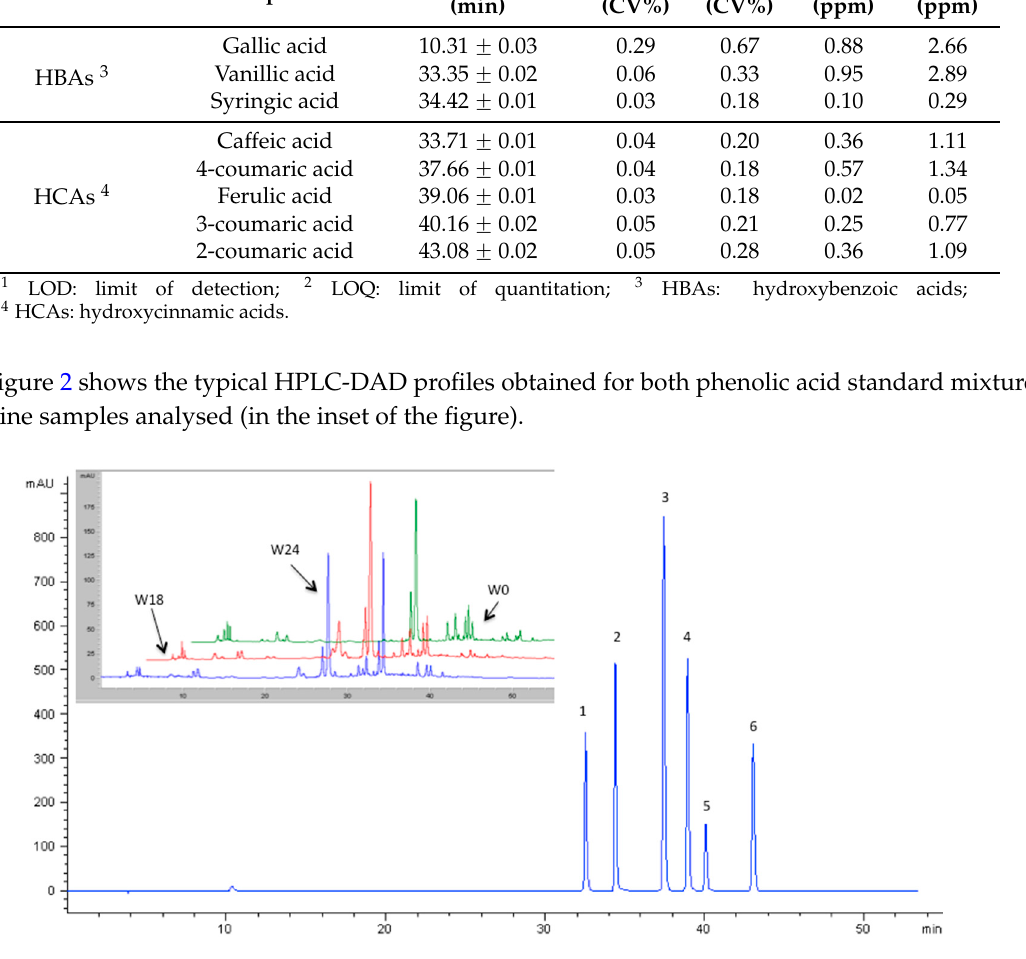
Figure 2. Typical HPLC-DAD chromatograms of phenolic acids and wine samples (in the inset) recorded at 320 nm. 1: caffeic acid; 2: syringic acid; 3: 4-coumaric acid; 4: ferulic acid; 5: 3-coumaric acid; 6: 2-coumaric acid.